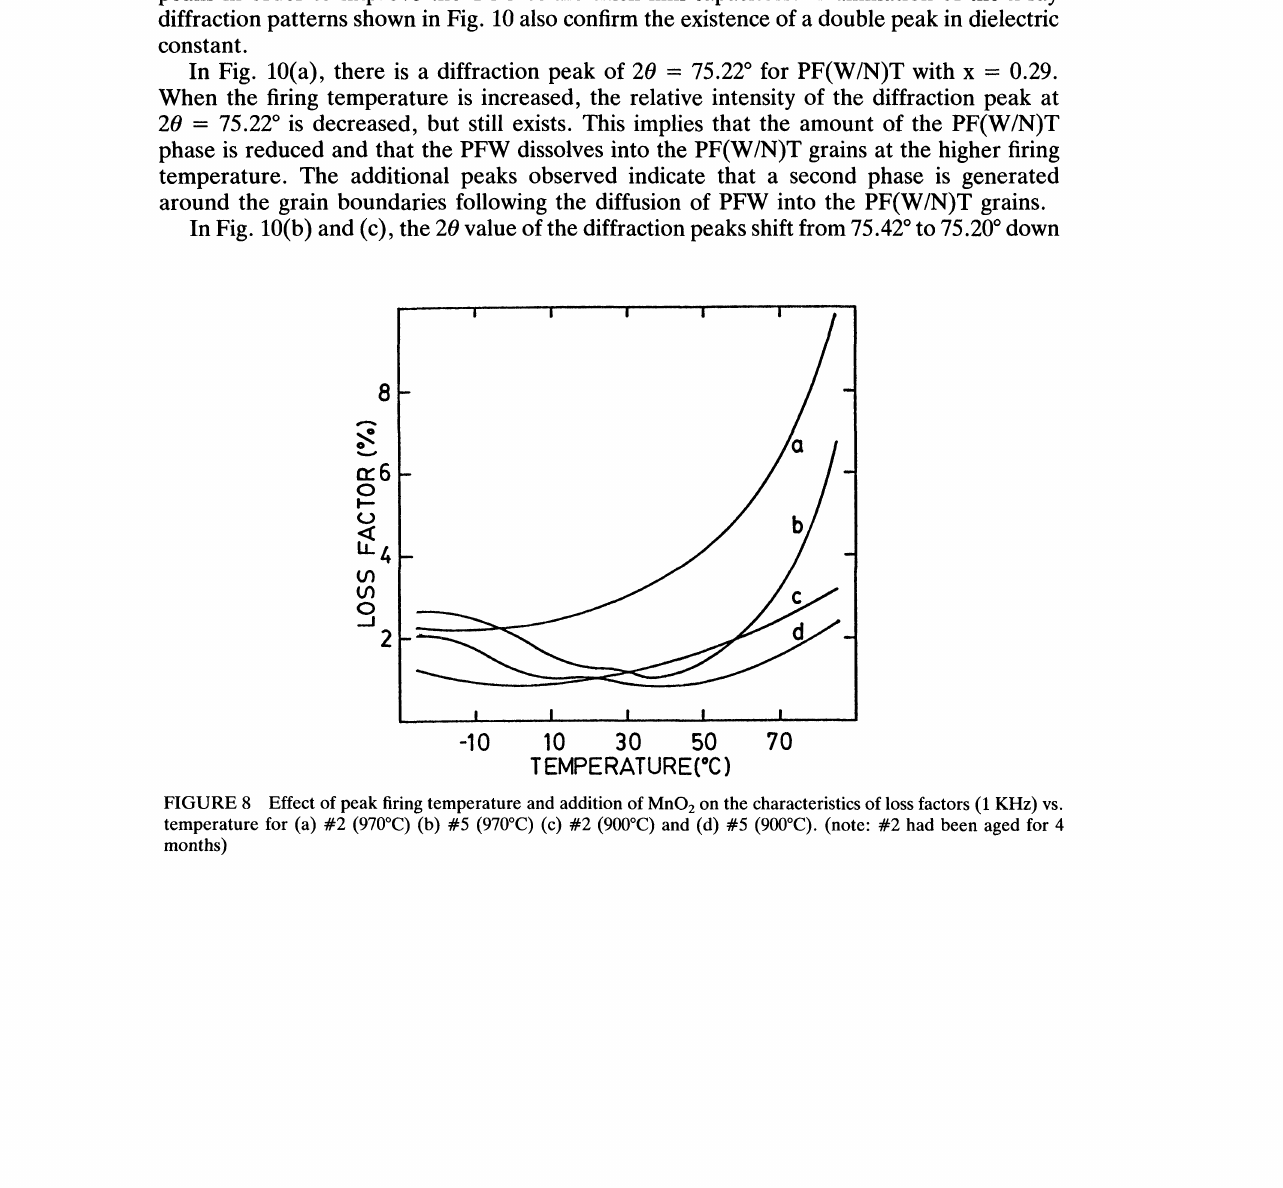
FIGURE 8 Effect of peak firing temperature and addition of MnO2 on the characteristics of loss factors (1 KHz) vs. temperature for (a) #2 (970C) (b) #5 (970C) (c) #2 (900C) and (d) #5 (900C). (note: #2 had been aged for 4